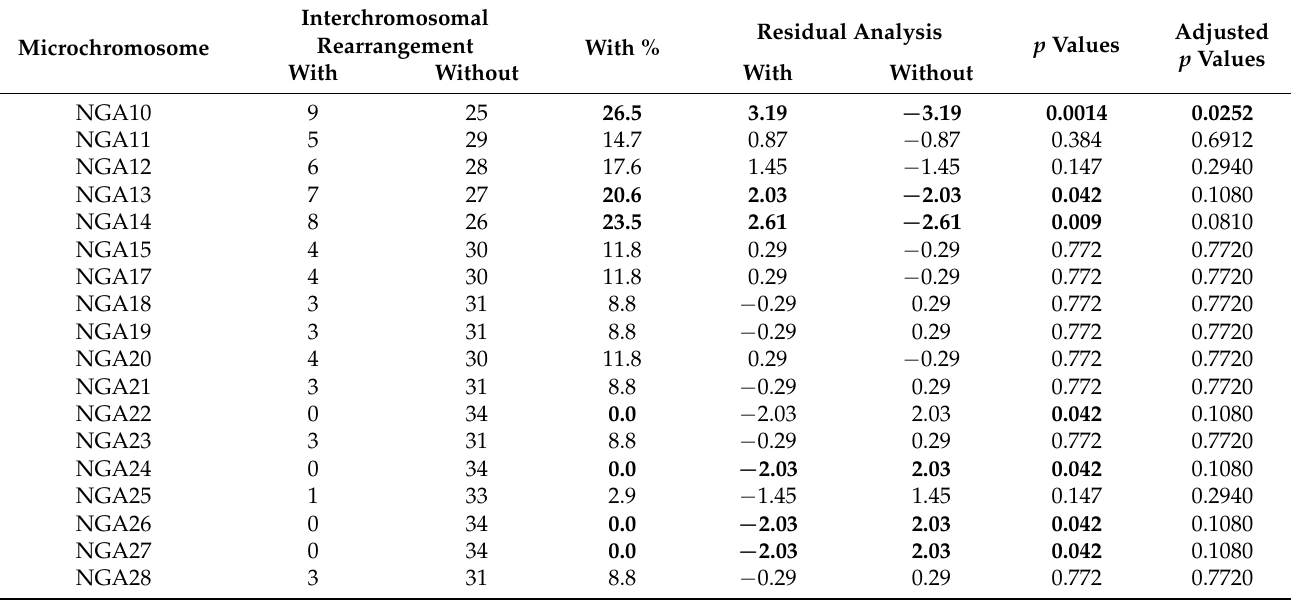
Table 3. Number of avian species with and without interchromosomal rearrangements in 18 microchromosomes, considering 34 avian species, which had been already studied with BAC probes for microchromosomes.